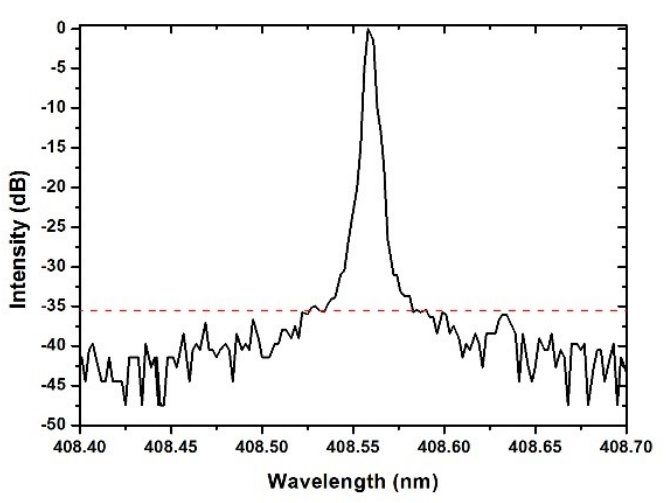
Figure 13. Spectral performance of a third-order DFB GaN LD exhibiting a SMSR exceeding 35 dB.